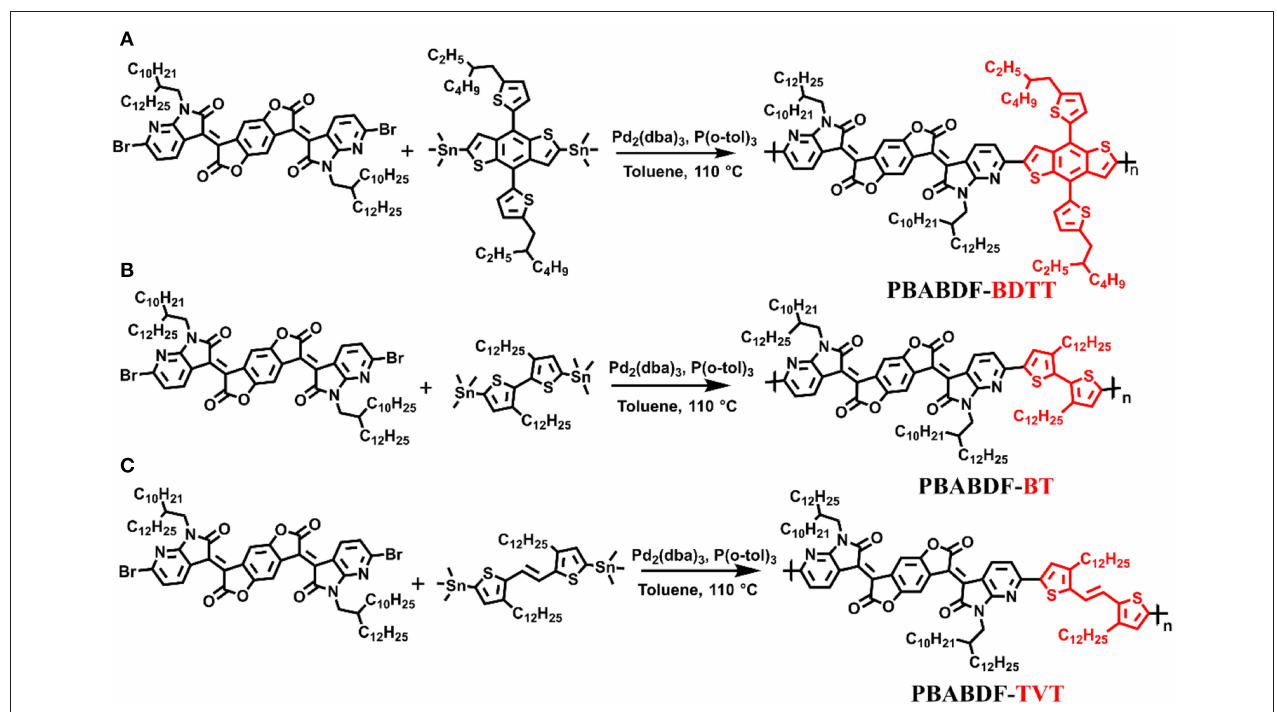
FIGURE 1 | Synthesis pathways for the CPs: PBABDF-BDTT (A) , PBABDF-BT (B) , and PBABDF-TVT (C)